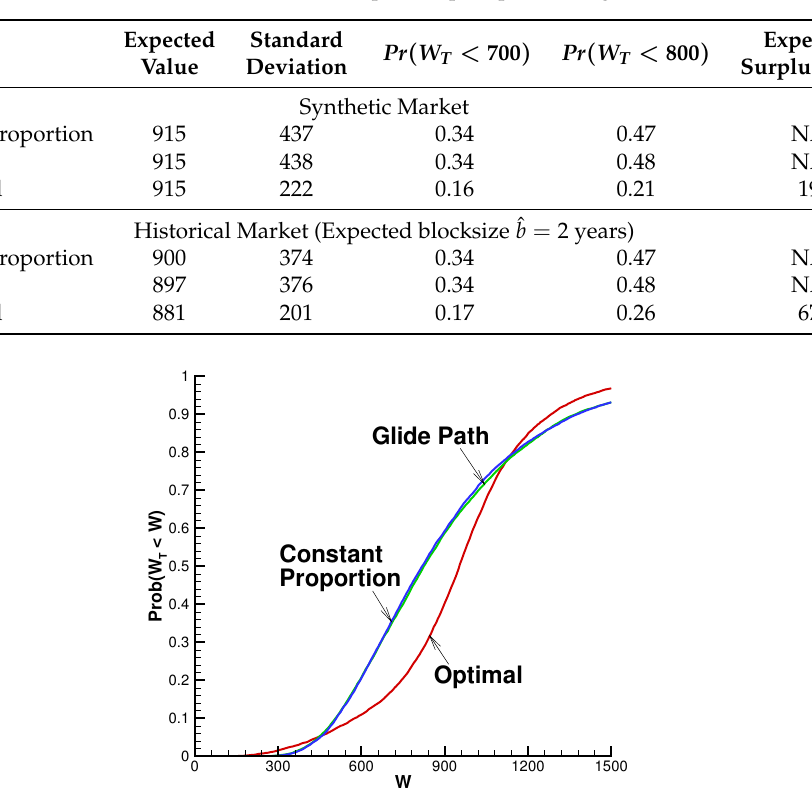
Table 8. Results for the optimal QS strategy when the 10-year T-bond index is used instead of the 3-month T-bill index. Wealth units: thousands of dollars. Input data provided in Tables 1 and 2, except as noted. Synthetic market results computed using Monte Carlo simulations with 160,000 sample paths.